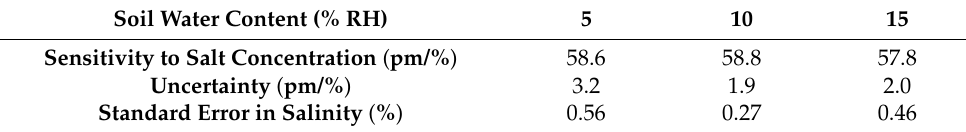
Table 5. Sensitivity of POFBGs (pm/ ◦ C) to NaCl concentration at 5%, 10% and 15% soil water